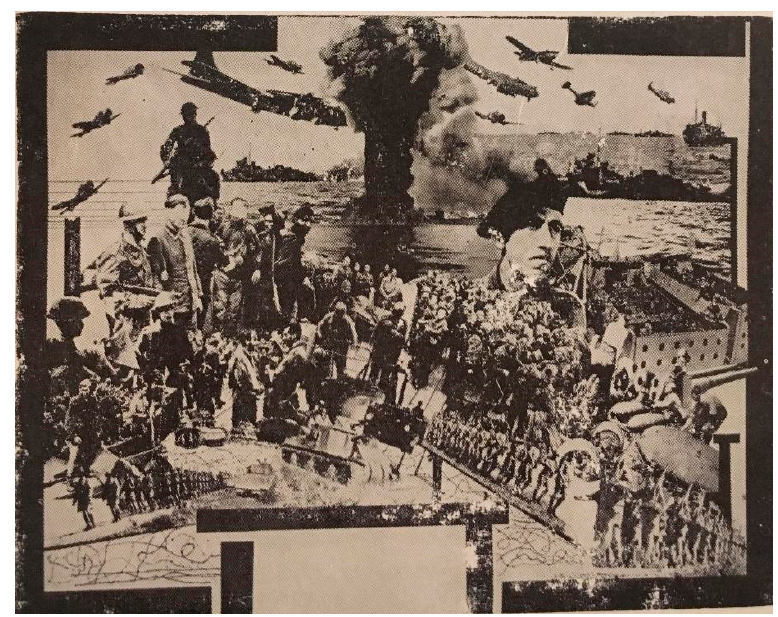
Figure 10. Teresa Ż arnower, Photomontage for Canadian troops , 1942, The New York Public Library, Figure 10. Teresa ˙Zarnower, Photomontage for Canadian troops , 1942, The New York Public Library, public public domain image. domain